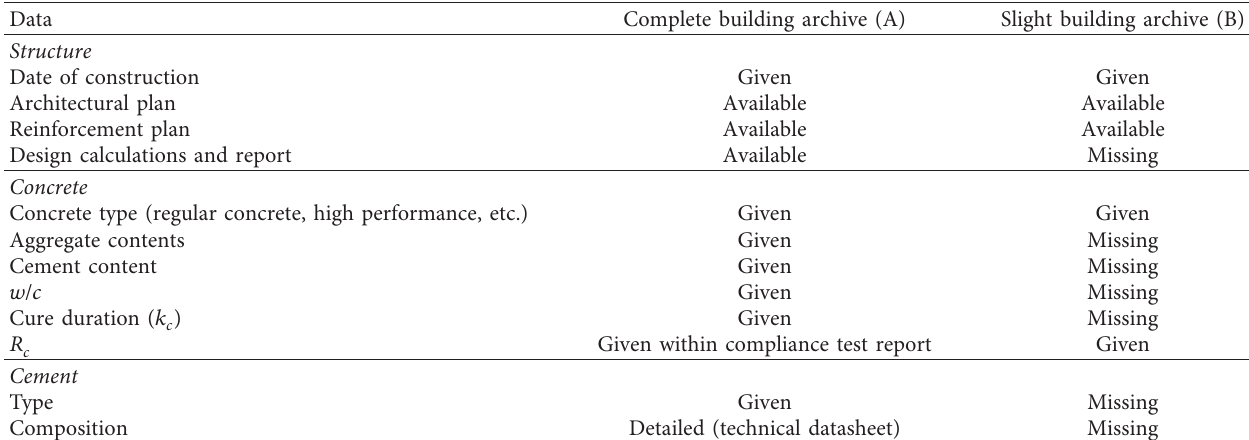
Table 12: Building archives of the 2 considered structures A and B.